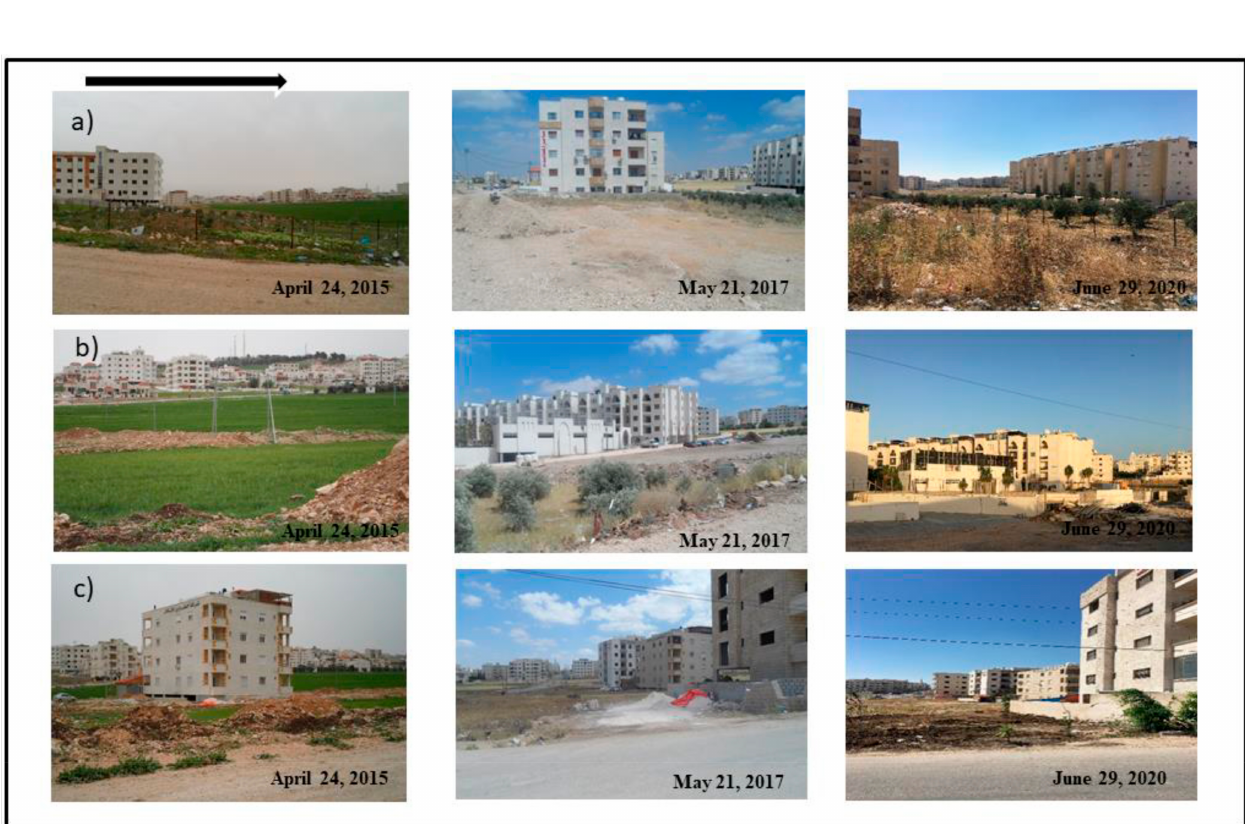
Figure 4. Timeline of photos for accuracy assessment of SLEUTH-3r projections in 3 sites located in Idoon from 2015–13 2020. These sites ( a – c ) are denoted in Figure 1. Photos taken by the